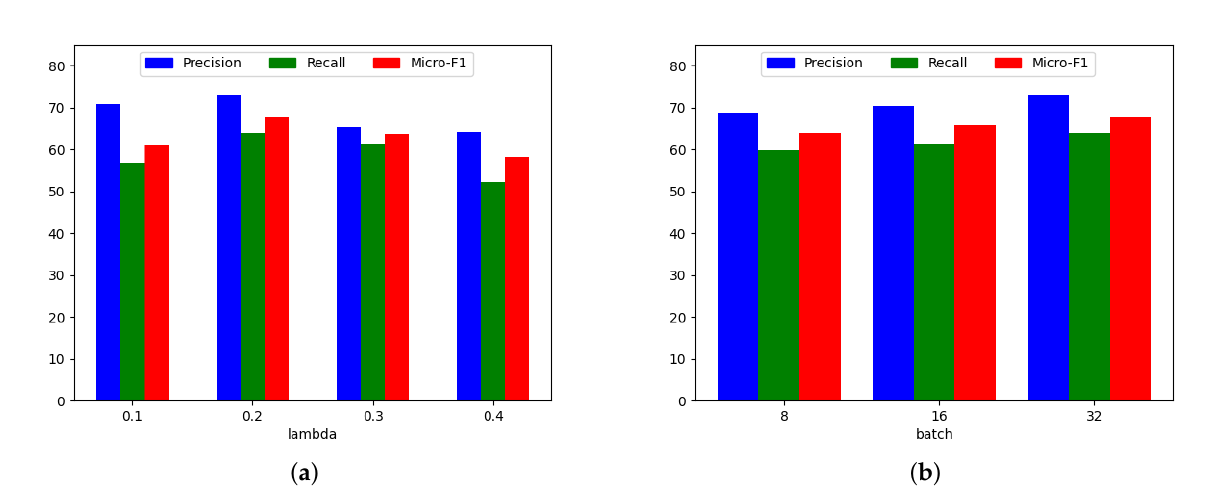
Figure 9. The impact of hyperparameter on the overall performance of the model. ( a ) The impact of λ . ( b ) The impact of